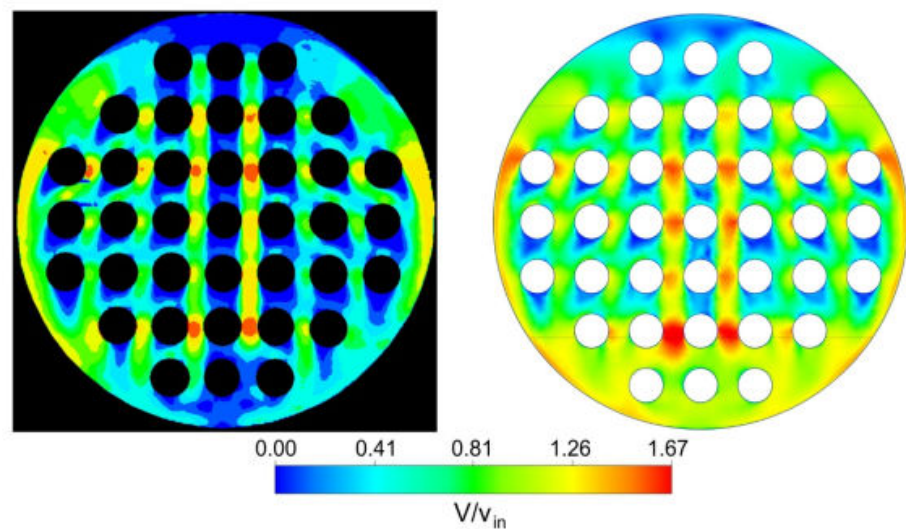
Figure 11. Comparison of scalar velocity fields V / v in for Q = 7.5m 3 / h (CFD on the right, PIV on the left).